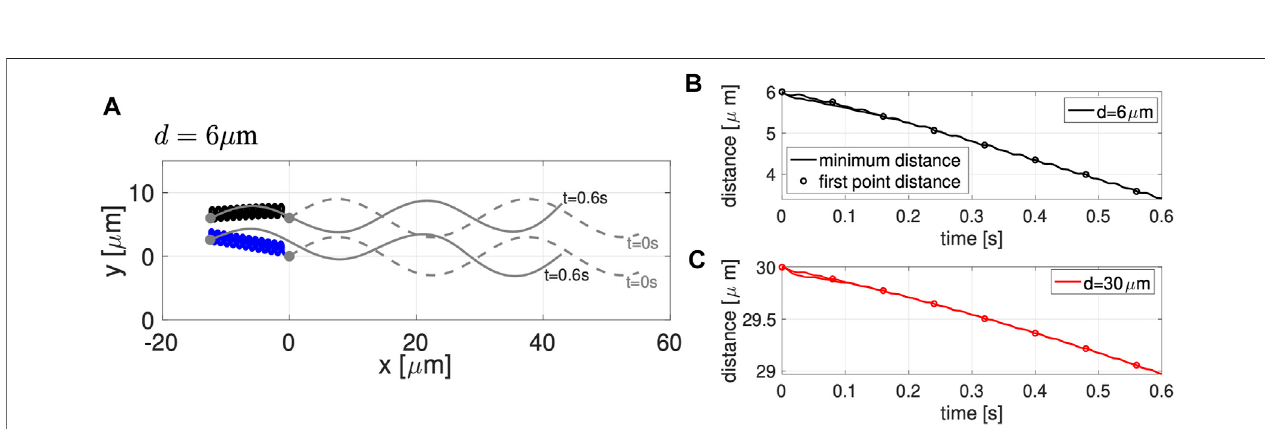
FIGURE 2 | Co-Planar Sperm in Free Space. (A) Swimmer con fi gurations with planar preferred beat forms at t (cid:1) 0 s (dashed gray lines) and t (cid:1) 0.6 s (solid gray lines), and traces of the fi rst point on the swimmer in time (blue and black solid lines) for the initial separation distance of d (cid:1) 6 μ m. Minimum distance between the two sperm (solidlines)and distance betweenthe fi rstpoints ofthetwoswimmers (circles)intime,forinitialdistances d (cid:1) 6 μ m (B) and d (cid:1) 30 μ m (C) .Distancesreportedare the average over a beat period.